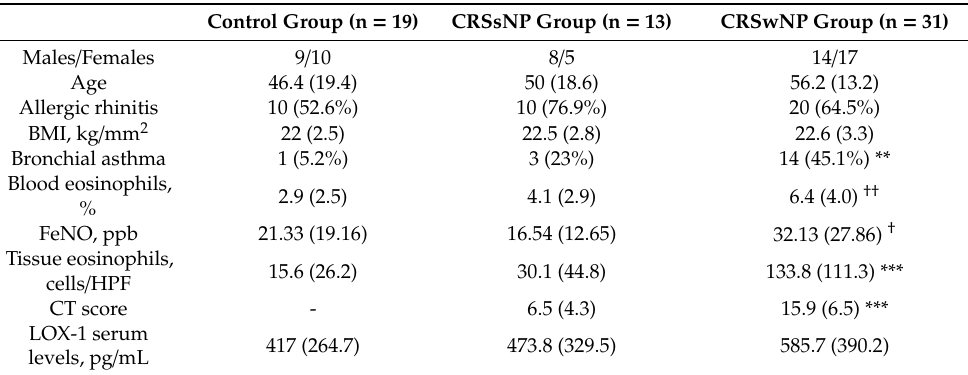
Table 1. Demographics and clinical background of the study population.